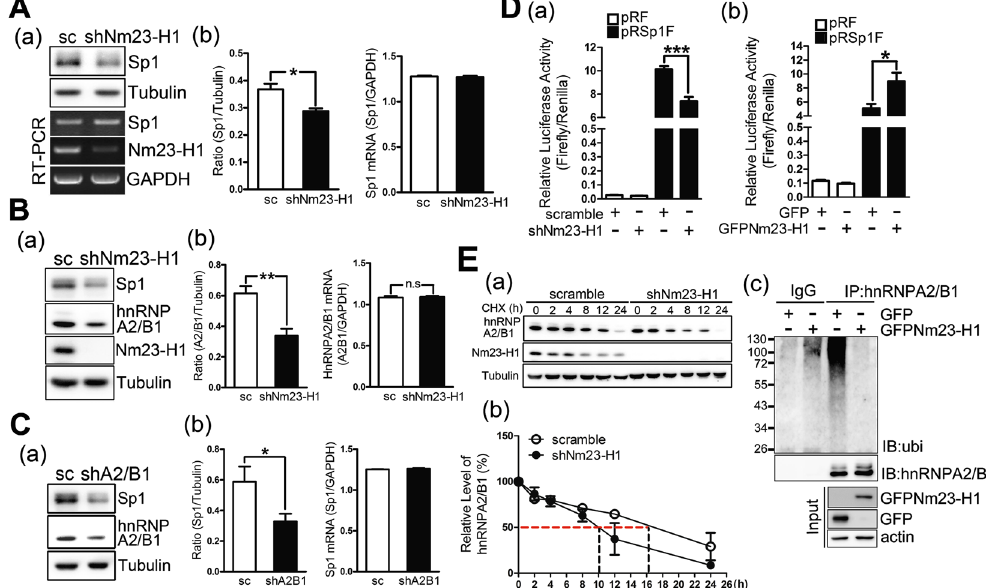
Figure 3. Nm23-H1 regulates Sp1 and hnRNPA2/B1. ( A – C ) Nm23-H1 ( A , B ) or hnRNPA2/B1 ( C ) was knocked down in CL1-5 cells; thus, the mRNA and protein samples were harvested for real time-PCR and Western blotting with antibodies against indicated proteins. After three independent experiments, the levels of the proteins and mRNA were quantified and statistically analyzed with a t-test, * p < 0.05; ** p < 0.01. ( D ) The pRF and pRSp1F plasmids were transferred into lung cancer cells with Nm23-H1 knockdown (a) or GFP- Nm23-H1 overexpression (b). After 24 h of incubation, cell extracts were collected for a luciferase activity assay and analyzed with t-test, * p < 0.05; *** p < 0.005. ( E ) Cells with or without knockdown of Nm23-H1 were treated with cyclohexmide. Samples harvested at the indicated time points were analyzed by Western blotting with antibodies against hnRNPA2/B1, Nm23-H1 and tubulin (a). After three independent experiments, the protein level of hnRNPA2/B1 was quantified (b). Samples were harvested from H1299 cells with or without GFP-Nm23-H1 expression treated MG132 (10 μ M) for IP with anti-hnRNPA2/B1 antibodies, and then samples were analyzed by Immunoblotting assay with indicated antibodies